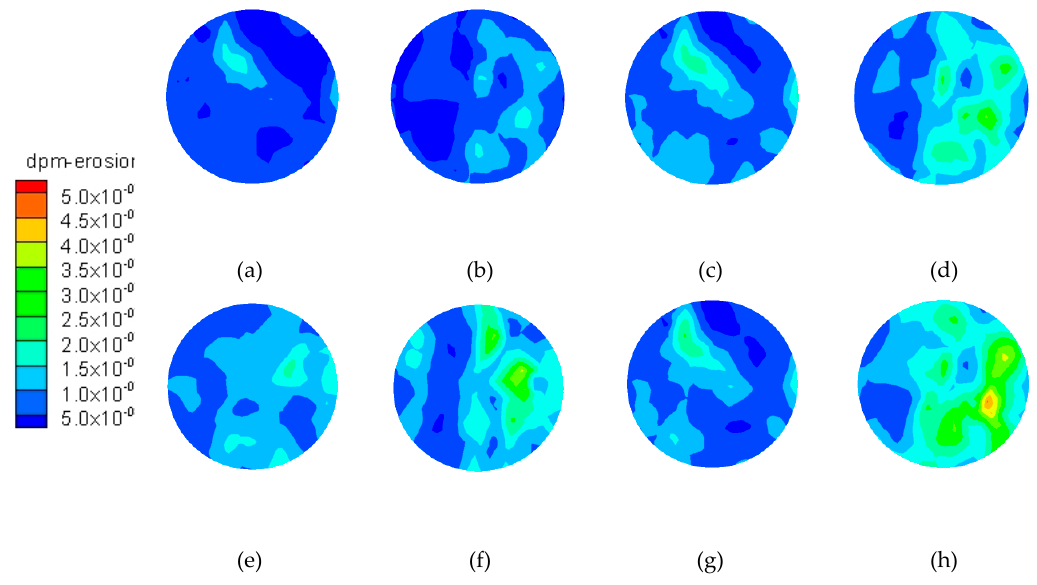
Figure 17. Wear contours of test samples at different particle inlet velocities: (a) condition set 9, 225mm; (b) condition set 9,316mm; (c) condition set 10, 225mm; (d) condition set 10, 316mm; (e) condition set 11, 225mm; (f ) condition set 11, 316mm; (g) condition set 12, 225mm; (h) condition set 12, 316mm.